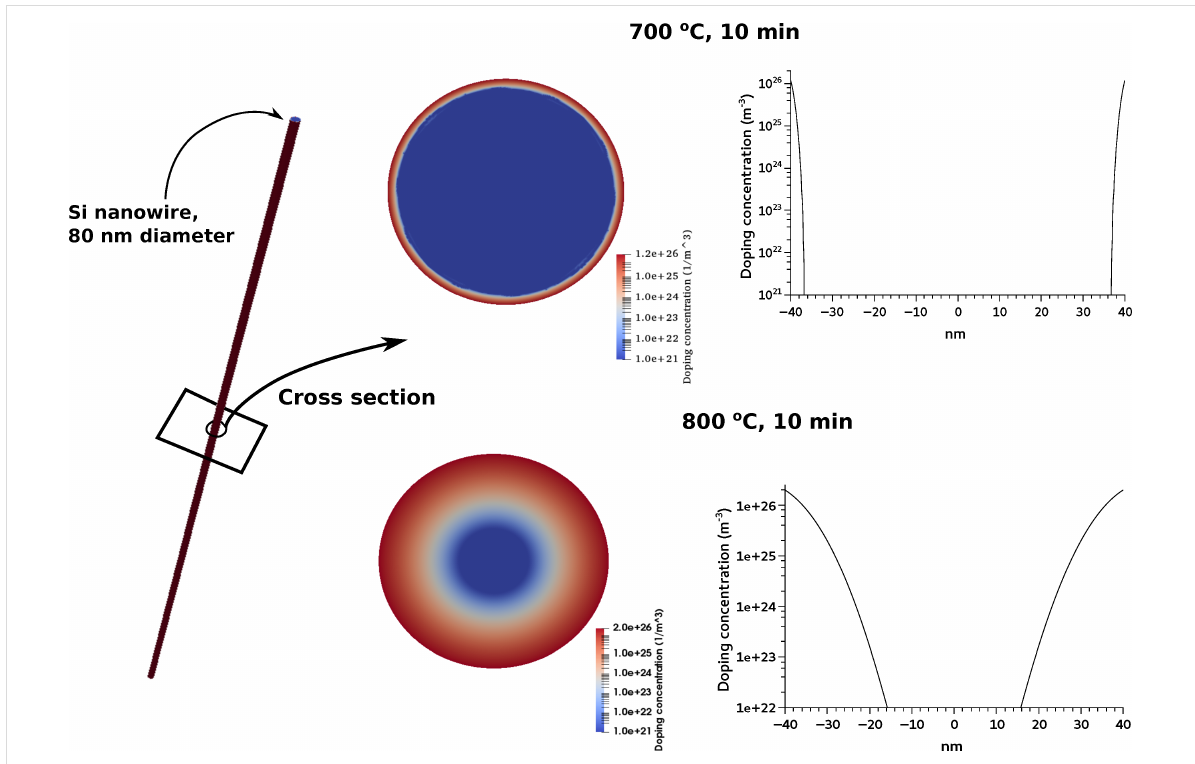
Figure 4: Numerical simulations of phosphorous diffusion in silicon nanowires. The doping concentration is maximum on the surfaces and decreases exponentially along the radius toward the center.